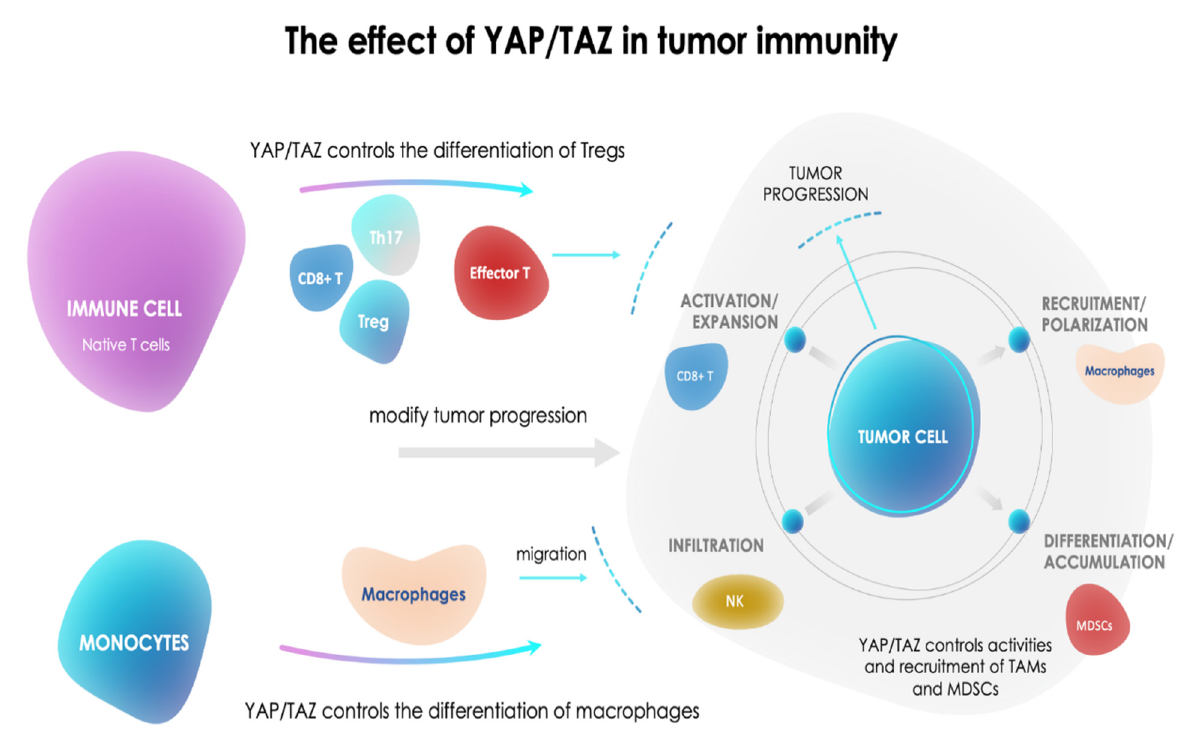
Figure 2. The role of YAP/TAZ in tumor immunity. YAP/TAZ expression in immune cells controls the differentiation and activities of Tregs and macrophages, which change the effector T-cell activity and tumor progression. YAP/TAZ expression in turn controls the activities and recruitment of tumor-associated macrophages (TAMs) and myeloid-derived suppressor cells (MDSCs), contributing to a modification of tumor progression.